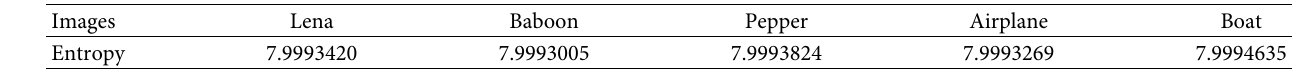
Table 5: The global entropy test results.